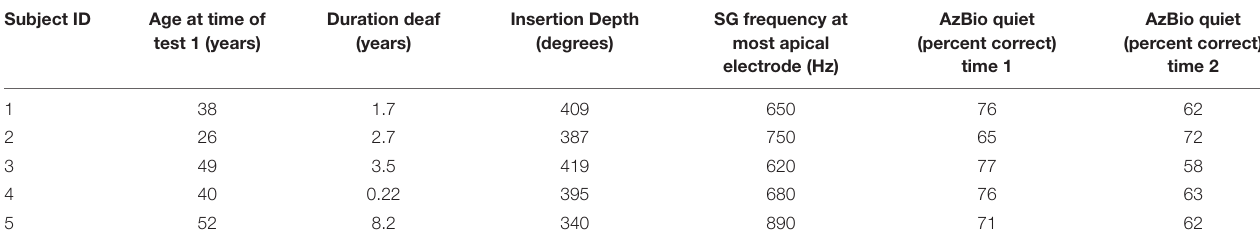
TABLE 1 | Selected biographical data for